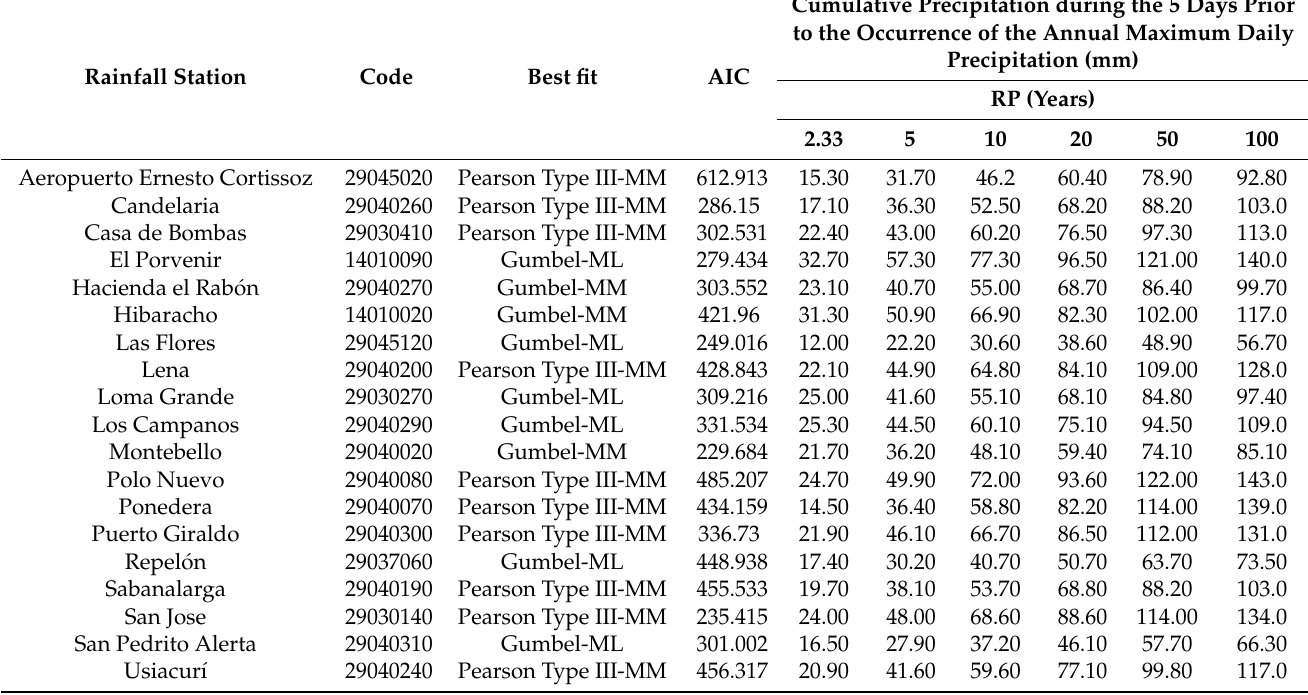
Table A5. Distribution of best